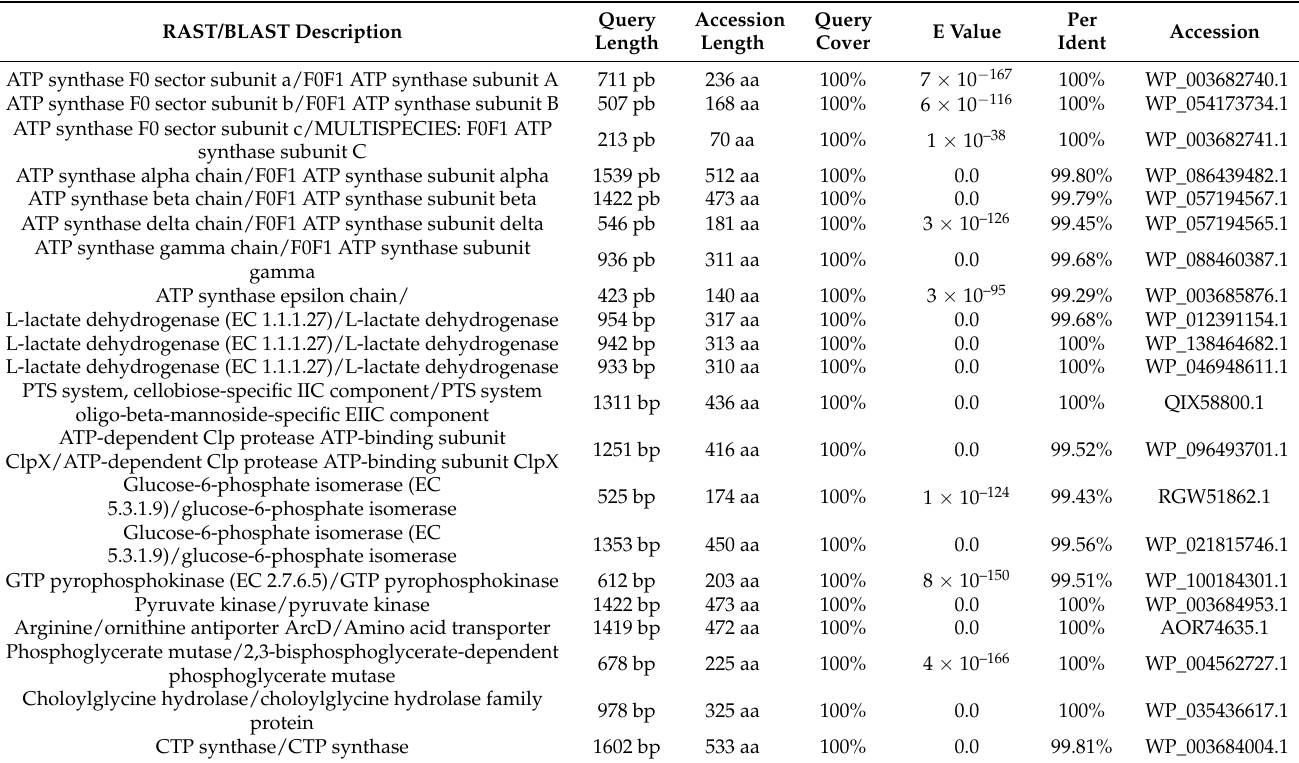
Table 2. Genes possibly involved in acid and bile salt tolerance detected in the L. fermentum ATCC 23271 genome. RAST/BLAST Description